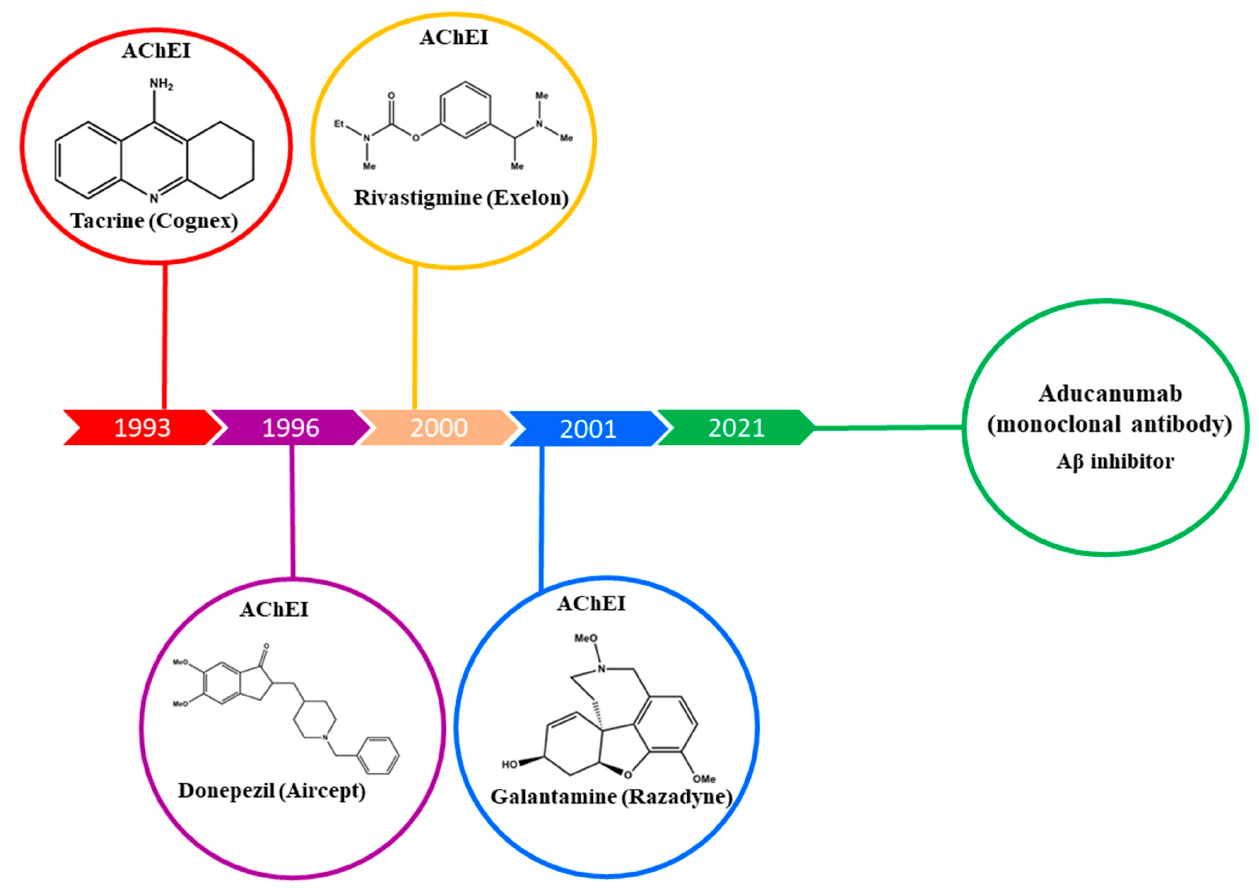
Figure 1. Current cholinesterase inhibitors and A β inhibitors are in clinical use (with trade names in parentheses), together with the years in which they received approval by the FDA.